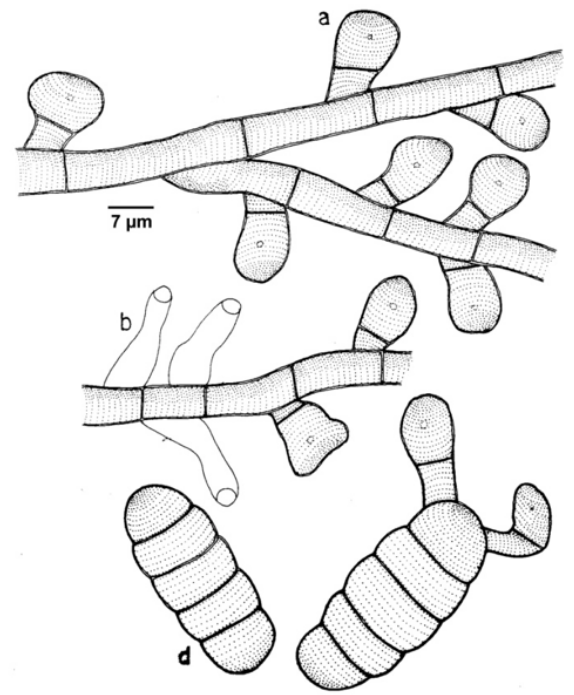
Figure 3. Amazonia gordoniicola a - Appressorium; b - Phialide; d -